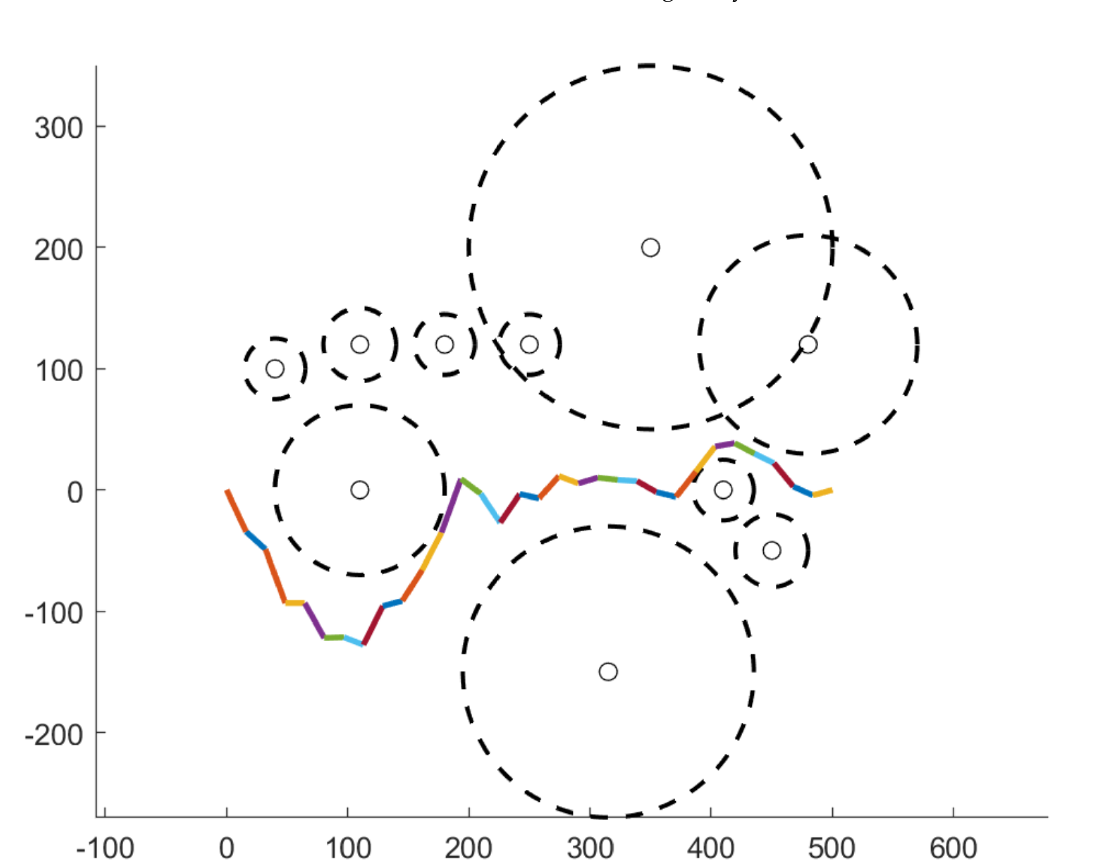
Figure 2. A case with ten threats. The horizontal axis is the length of the battlefield and the vertical axis is the width of the battlefield. The unit can be any unit that represents the